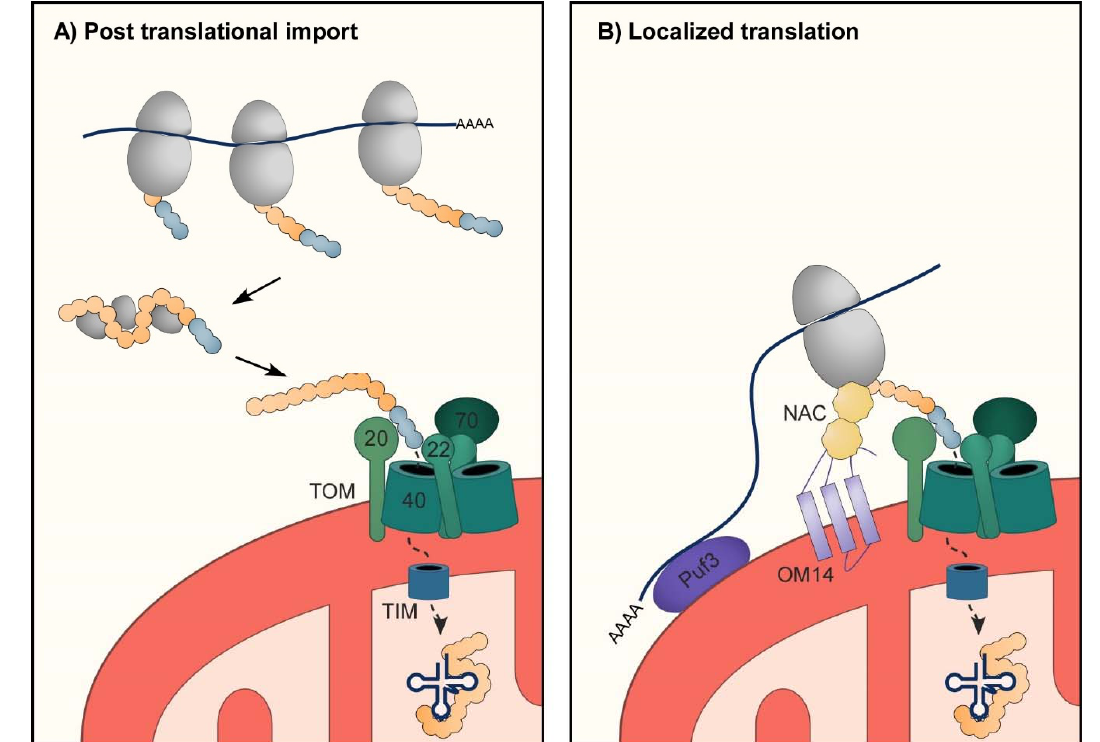
Figure 1. Protein import into mitochondria. ( A ) Mitochondria-destined proteins are translated by cytosolic ribosomes and maintained in an unfolded state by various chaperones. Many of these (including all mitochondrial aminoacyl tRNA synthetases (mt-aaRSs)) bare an N-terminal Mitochondria Targeting Signal (MTS, blue spheres) that enables recognition by protein a receptor on the mitochondria outer membrane (Tom20 for mt-aaRSs). Recognition is followed by insertion through the Tom40 pore and distribution into mitochondria sub-compartments. All mt-aaRSs are transferred through the Translocase of the Inner Membrane (TIM) into the matrix. The MTS of many matrix destined proteins, such as mt-aaRSs, is removed and cleaved by the Mitochondrial Processing Protease (MPP), resulting in a mature, MTS-deficient enzyme. ( B ) Mitochondria proteins can also be imported by a mechanism that involves localized translation near the mitochondria outer membrane [31]. The nascent MTS can interact with Tom20 while the protein is being translated. Furthermore, ribosome-associated chaperones (i.e., Nascent chain Associated Complex (NAC)) can interact with an outer membrane protein (OM14) and support protein import. Finally, the RNA-binding protein Puf3 protein assists in mRNA localization to mitochondria, presumably through interaction with the outer membrane. Notably, while all mt-aaRS mRNAs appear to localize near mitochondria, this localization is only partially affected by Puf3 or Tom20 deletion (Table 1), suggesting a novel mechanism for localization.